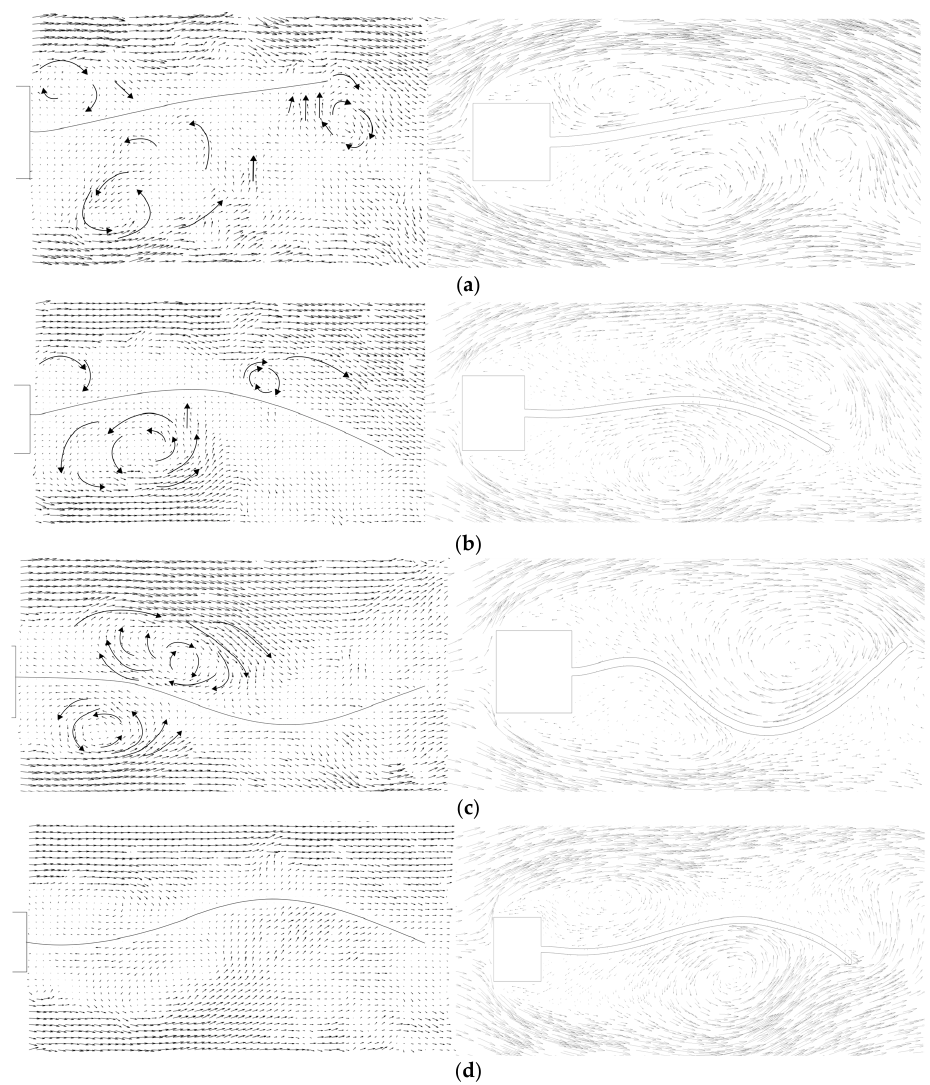
Figure 7. Comparison between the velocity vectors given by PIV and simulations for characteristic shapes, t p = 100 µm, W = 10 mm ( a ) L = 50 mm at RE = 12,295, ( b , c ) L = 75 mm at RE = 14,279, ( d ) L = 100 mm at RE = 14,279.